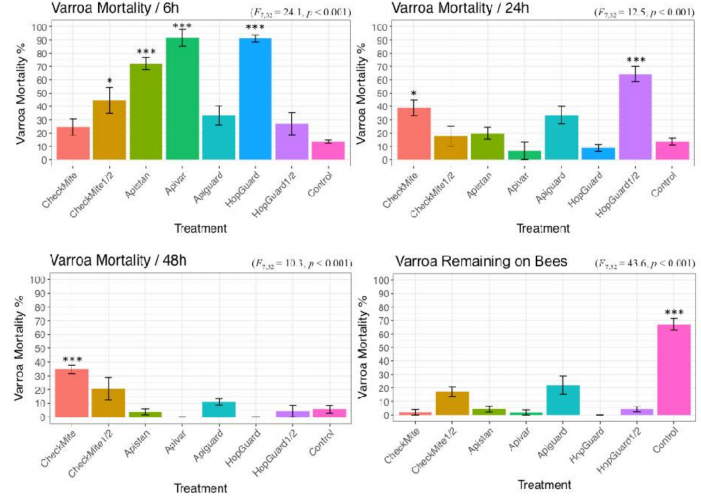
Figure 3. Varroa mite mortality recorded in each caged-bee group at intervals of 6, 24, and 48 h. Groups were exposed to a CheckMite ® 1 dose, CheckMite ® 1 ⁄ 2 dose, Apistan ® , Apivar ® , Apiguard ® , HopGuard ® 1 dose, HopGuard ® 1 ⁄ 2 dose, or left untreated (control group). The term ‘remaining’ denotes the percentage of Varroa that survived after 48 h of exposure. Asterisks show ANOVA significance levels for pairwise comparisons between the control and each acaricidal treatment and they are as follows: p < 0.05 * and p < 0.001 ***. Bars denote the mean Varroa mortality (%) ± 1 standard error